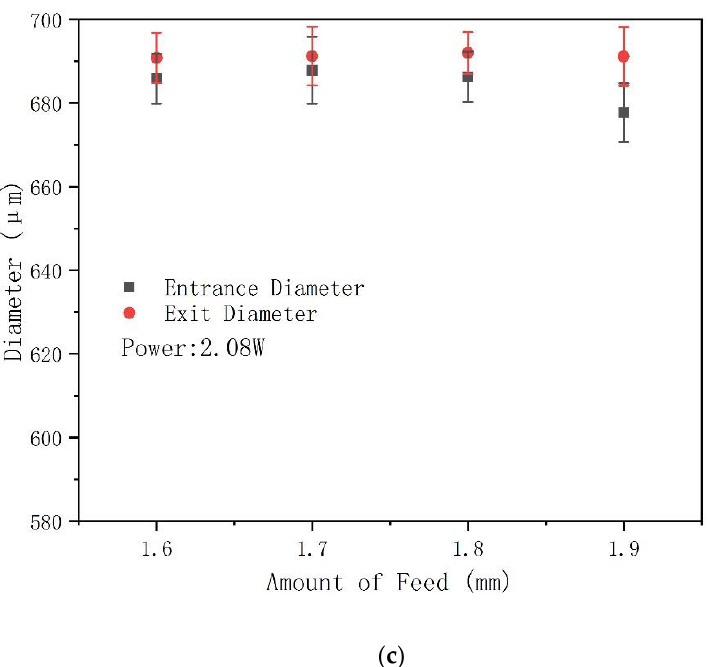
Figure 10. Variation of the entrance and exit holes’ diameters obtained by using different laser power (( a ) 0.7 W, ( b ) 1.39 W, ( c ) 2.08 W; repetition rate: 50 KHz; rotational speed of laser: 2400 rpm; feed speed of Z movement: 10 mm/s; drilling cycle: 25 passes) and drilling depth (1.6 mm to 1.9 mm) on 2 mm thick CFRP plates.